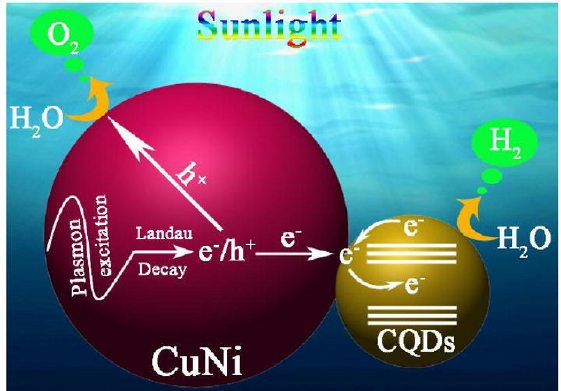
Figure 6. A scheme showing the mechanism of water splitting on CuNi/CQDs photocatalyst. Copyrights 2019 Elsevier [91].